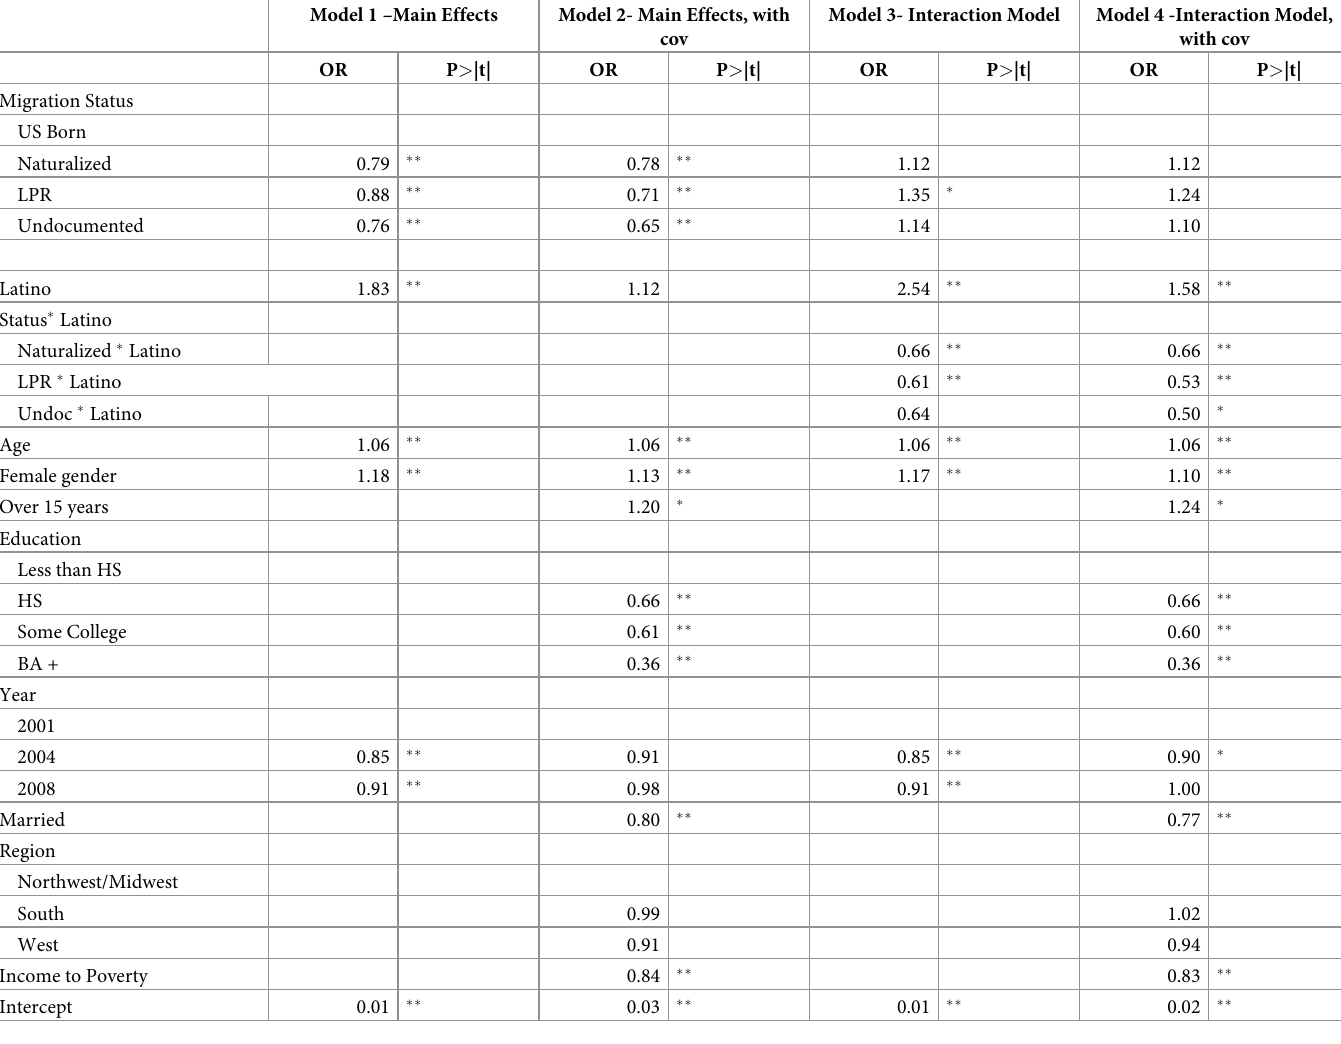
Table 2. Logistic regression for immigration status and poor/fair self-rated health, main effects and interaction between race/ethnicity, 2001/2004/2008